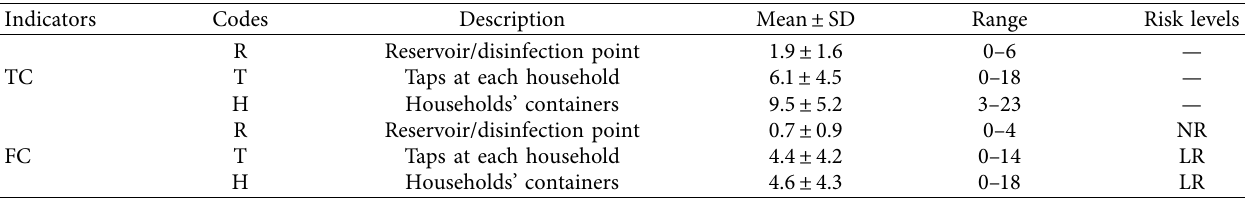
Table 1: Coliform counts (CFU/ml) in the drinking water samples from the reservoir, taps, and households’ containers in Addis Kidame Town, 2020.